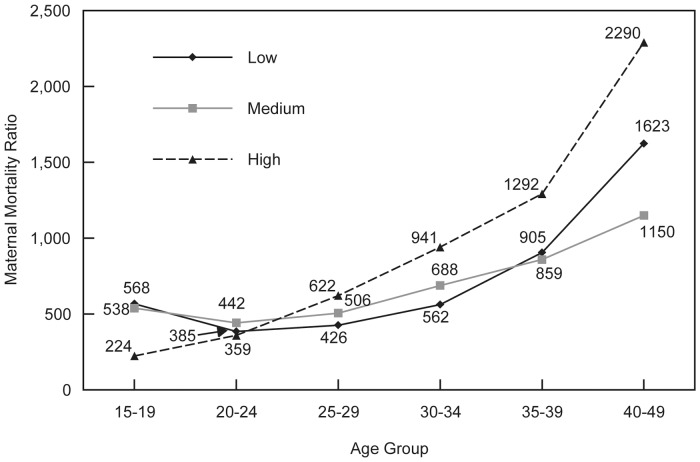
Maternal mortality ratios, sub-Saharan African countries by HIV prevalence.The maternal mortality ratio (MMR) is the number of maternal deaths per 100,000 births. Sub-Saharan African countries are grouped by the overall level of HIV prevalence in 2006 (the median year of the surveys analyzed). Countries are grouped into: high (>10%), medium (2–10%), and low (<2%) prevalence.